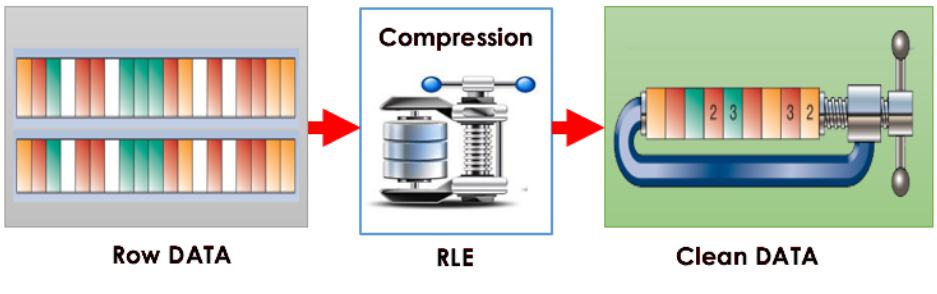
Figure 5. Data reduction.